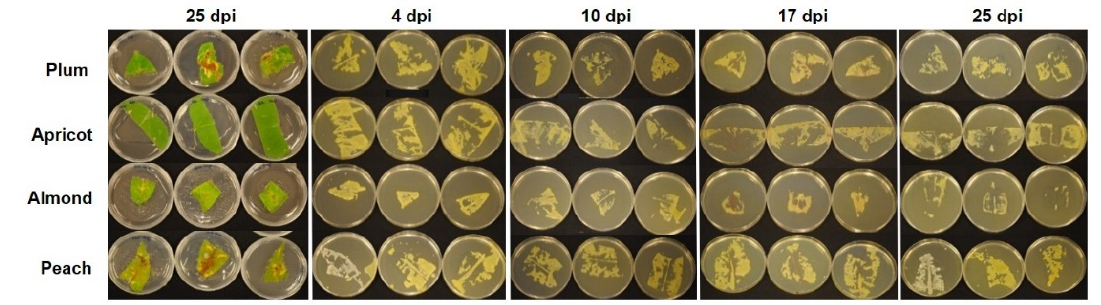
Figure 8. CITA 33 biofilm viability ex vivo. Imprints of detached leaves from plum, apricot almond and peach on LB medium at 4, 10, 17 and 25 dpi. First column showed the symptoms 25 dpi.